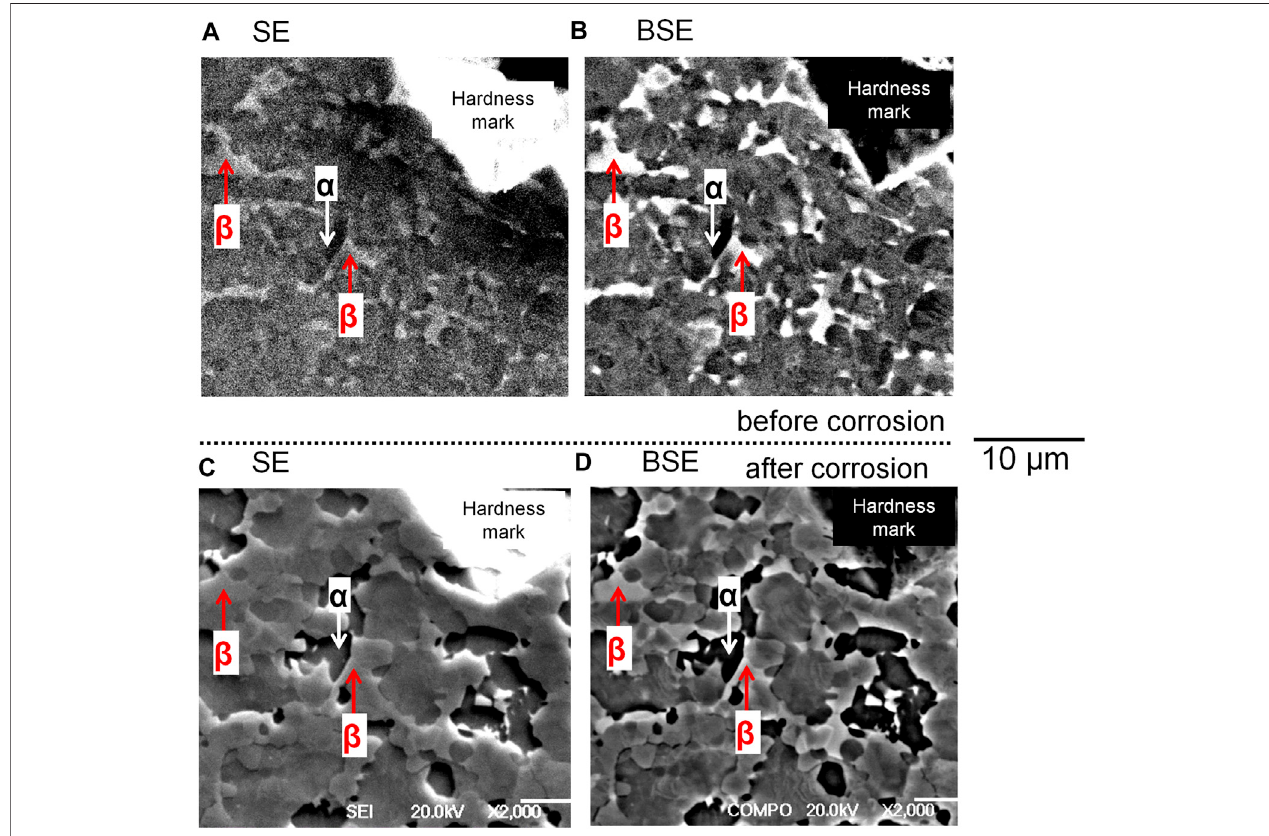
FIGURE 4 | SEM image of mirror-polished Ti6Al4V (A,B) before and (C,D) after potentiostatic test in 2 M HCl at − 510 mV vs. SCE for 30 min at 37 ° C. SE: secondary electron mode SEM image; BSE: back scattered electron mode SEM image.